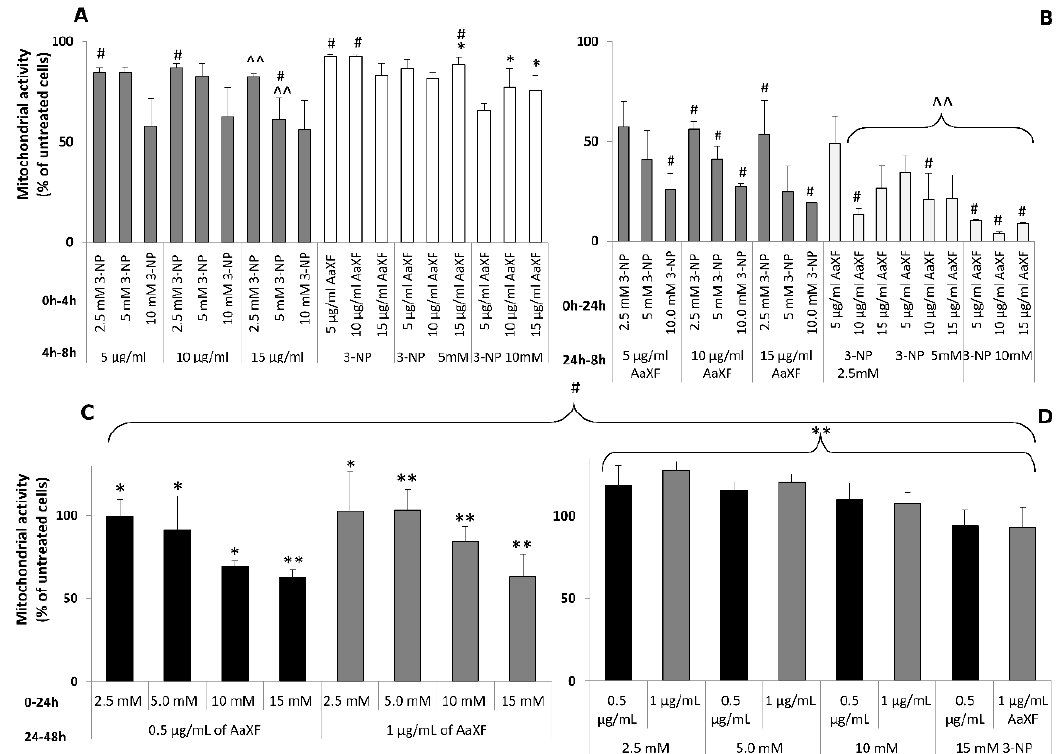
Figure 3. Mitochondrial activity of PC12 cells which were treated with various concentrations of XF (5, 10, and 15 μ g/mL), interchangeably with 3-NP (2.5, 5, 10 mM) for 8 h ( A ) and 48 h ( B ), grey bars represent pre-incubation with 3-NP and the white bars represent pre-incubation with the XF. Mitochondrial activity of PC12 cells which were treated with very low concentrations of XF (0.5 and 1 μ g/mL), interchangeably with 3-NP (2.5, 5, 10, 15 mM) for 48 h (( C ) pre-incubation with3-NP, ( D ) pre-incubation with the XF). The mitochondrial activity of cells was measured using the 3-(4,5-dimethylthiazol-2-yl)-2,5-diphenyl tetrazolium bromide (MTT) assay. Data represent the mean ± SD of reduction in cell viability of five independent experiments. Significantly higher from the corresponding 3-NP treatments group at * p < 0.05 or ** p < 0.005 and significantly lower from the corresponding 3-NP treatments at ^ p < 0.05 or ^^ p < 0.005. # indicates statistically significant ( p < 0.05) difference between means of 3-NP pre-incubation vs. XF pre-incubation at the same concentrations.